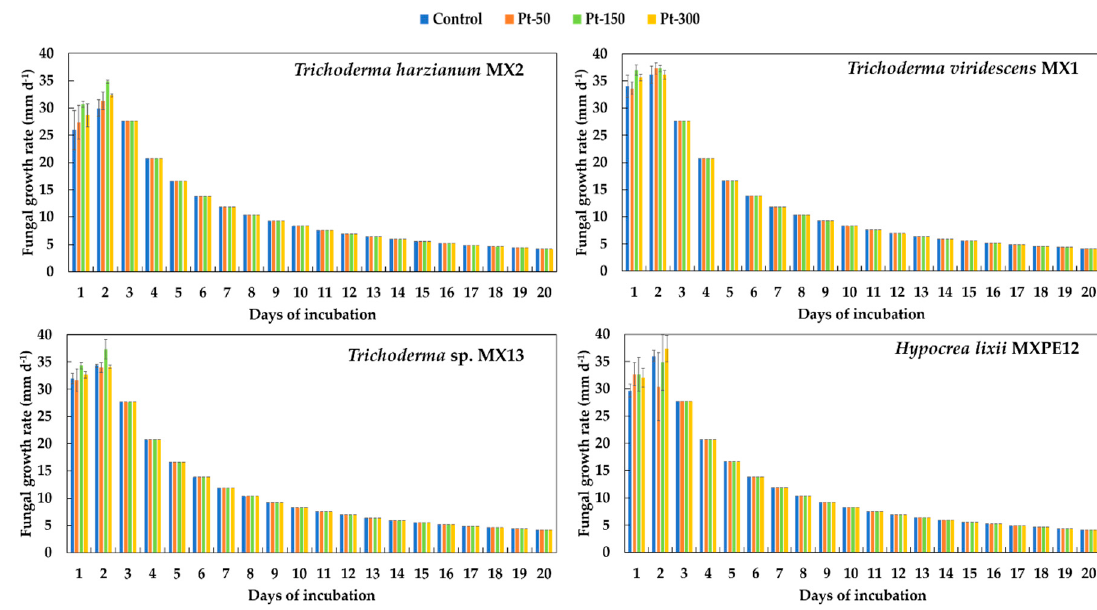
Figure 7. Fungal growth rates of four filamentous fungi strains exposed to four doses of platinum (mg L − 1 ) (n = 3, means ± standard error).